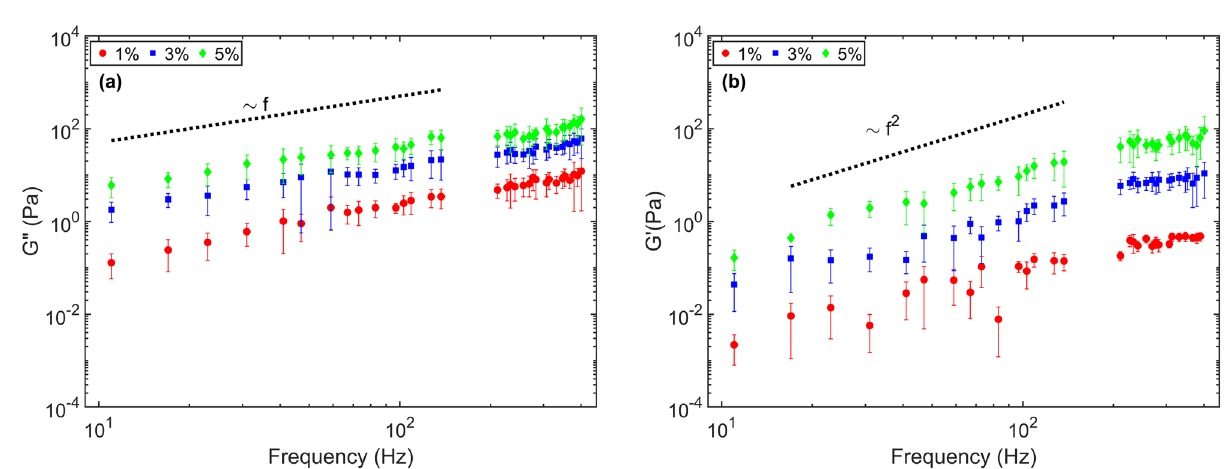
Figure 4. Complex modulus of the methylcellulose-water solution as a function of the driving frequency estimated by using the multi-frequency APC technique. ( a ) loss modulus of 1, 3 and 5% methycellulose- water solutions and ( b ) storage modulus of 1, 3 and 5% methycellulose-water solutions. Theoretically the Loss modulus scale as G ′′ ∼ f 1 and the storage modulus scale as G ′ ∼ f 2 indicated as black dotted Fig. 2. The possible reason for this feature is attributed to a resonance of the driving stage. A thorough investiga- tion of this resonance phenomena will be carried out in future. For this reason, we ignored the frequencies in the range from 150 to 200 Hz in the following measurements with methylcellulose. After performing measurements with glycerol, we carried out measurements in viscoelastic methylcellulose- water solutions. The loss and storage moduli resulting from the measurements of the different methylcellulose- water solutions are shown in Fig. 4a,b, respectively. The loss modulus for the solutions scales approximately as G ′′ ∼ f 0.9 . This trend is in line with the expected behavior according to polymer theory 48 , which is given by G ′′ ∼ f 1 (see black dotted line in Fig. 4a. The storage modulus is expected to scale as G ′ ∼ f 2 as shown by the dotted line in Fig. 4b) and a good agreement was found between the experimental results and the predicted scaling up to around 300 Hz. However, for larger frequencies, the experimental data for storage modulus scales as G ′ < f 2 . The drop in the power coefficient at higher frequencies results from the shear based thinning of methylcellulose. Shear thinning is a well-known non-Newtonian property of fluids whose viscosity decreases under an increased shear strain 49–53 . Ghannam and Esmai 50,51 have shown that the shear thinning depends on the concentration of carboxymethyl cellulose (CMC). Similarly, our measurements showed a similar trend for different concentrations of methylcellulose.